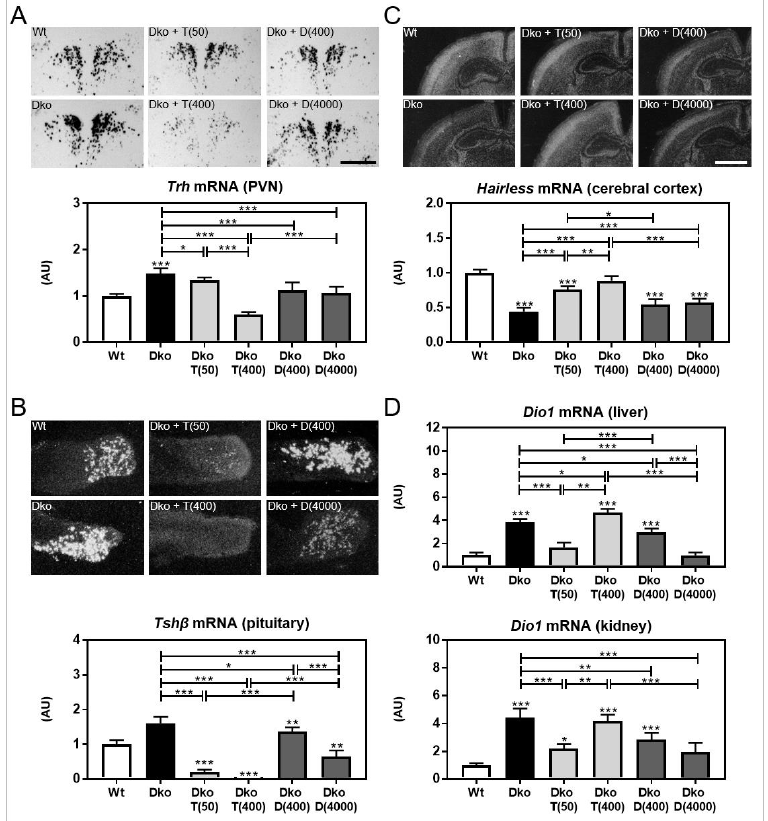
Figure 2. Triac executes stronger thyromimetic actions on the HPT axis than Ditpa. Dko mice were injected daily with either a saline solution or different concentrations of Triac and Ditpa between P1 and P20. At P21, activity of the HPT axis was monitored. ( A ) Saline-treated Dko mice exhibited strongly increased Trh -specific ISH signals in PVN neurons, which were reduced in intensity following Triac application in a dose-dependent manner. Ditpa had only little effect on Trh expression. Bright-field images are depicted while dark-field illuminations were employed for quantification. ( B ) Dark-field autoradiograms illustrate alterations in Tshb transcripts in the pituitary with increased levels in Dko mice that were almost completely suppressed by Triac application, but only moderately so by Ditpa treatment. ( C ) Hr -specific hybridization signals were used to examine thyromimetic effects of TH analogs in the brain. Centrally severely hypothyroid Dko mice present with strongly decreased hairless expression that was restored by Ditpa and, even more efficiently, by Triac application. ( D ) Hepatic and renal Dio1 expression were studied by qPCR. Mice receiving the low dose of Triac showed a reduction in Dio1 expression in both organs while high-dose Triac maintained elevated Dio1 transcript levels as seen in saline-treated Dko mice. Ditpa decreased Dio1 expression dose-dependently. n = 4–10. Scale bars 200 µ m ( Trh ), 500 µ m ( Tshb ), 1 mm ( Hairless ). *, p < 0.05; **, p < 0.01; ***, p <